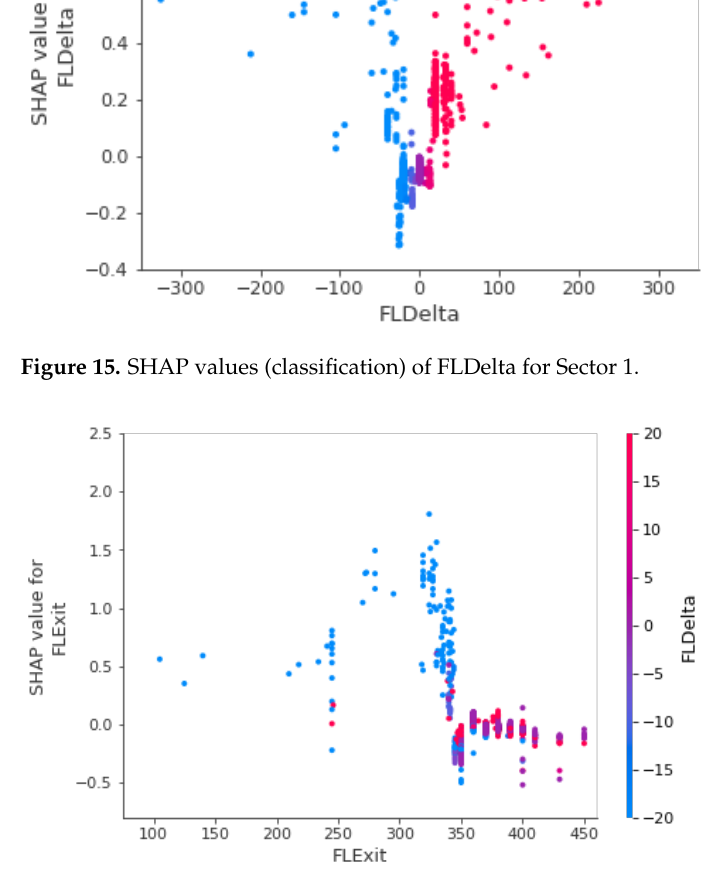
Figure 16. SHAP values (classification) of FLExit according to FLDelta for Sector 1.